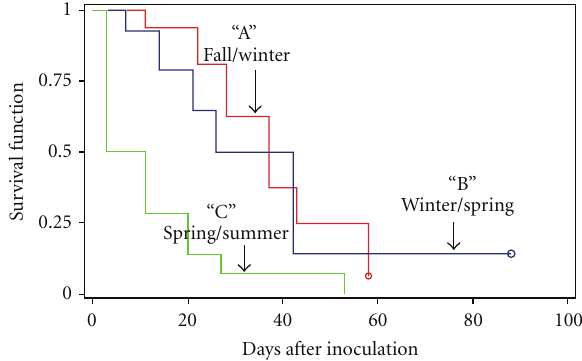
Figure 8: Survival probabilities of M. bovis exposed to natural environmental conditions in “A”, “B”, and “C” sampling